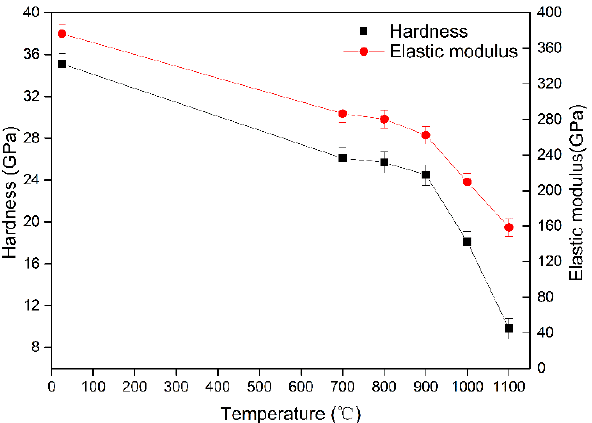
Figure 7. Variation of hardness and elastic modulus of the (AlCrTiZrMo)N/ZrO 2 nano-multilayered film with the ZrO 2 layer thickness of 0.6 nm after annealing at different temperatures for 30 min.